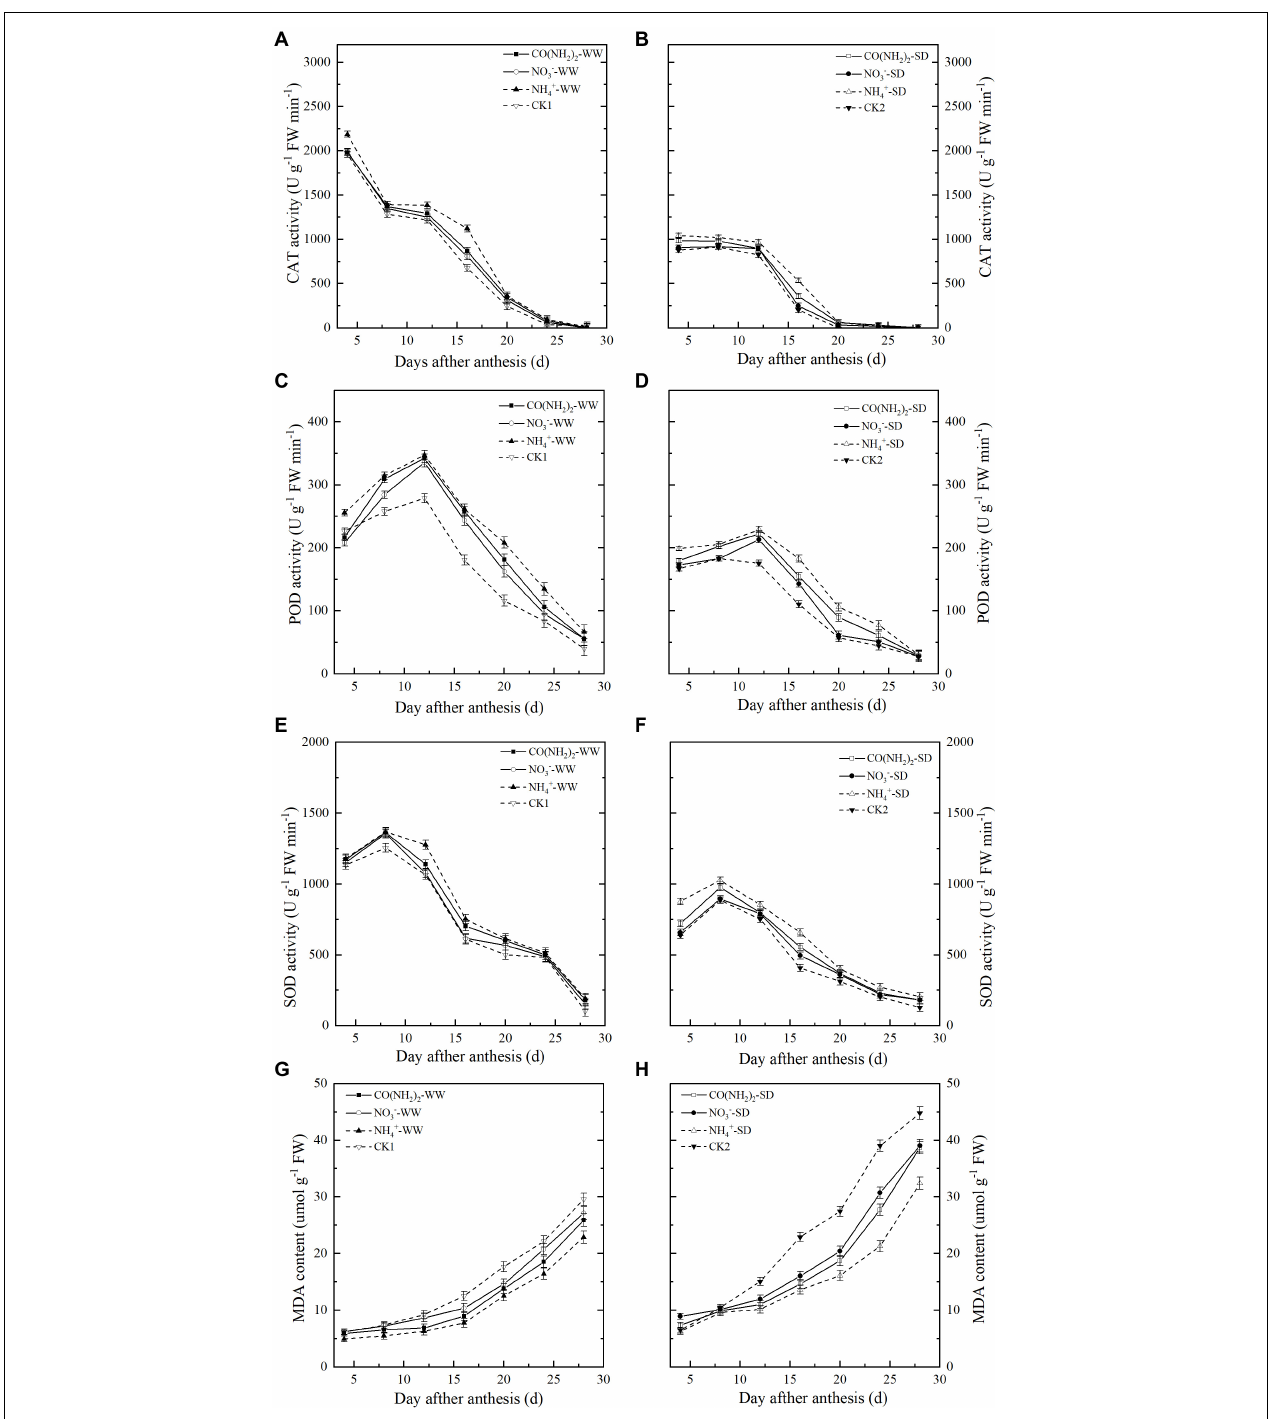
FIGURE 7 | Effect of N forms in foliar fertilizer on the CAT, POD, and SOD activity and MDA content in the wheat flag leaves [ (A,C,E,G) well-watered treatment, WW; (B,D,F,H) soil-dried treatment, SD]. Vertical bars represent ± the standard deviation of the mean ( n = 3). CO(NH 2 ) 2 , NO 3 − , and NH 4 + represent CO(NH 2 ) 2 , NaNO 3 , and NH 4 Cl, whose concentration was described in Materials and Methods. CK1 and CK2 mean that deionized water was sprayed on leaves at anthesis under well-watered treatment and soil-dried treatment, respectively.